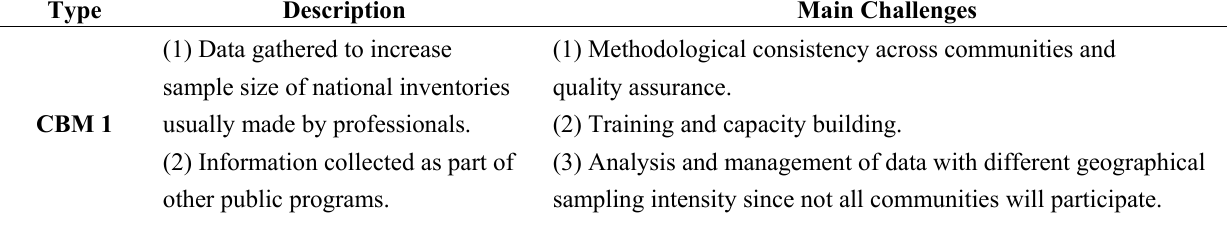
Table 1. Description of general opportunities for CBM in REDD+ and main